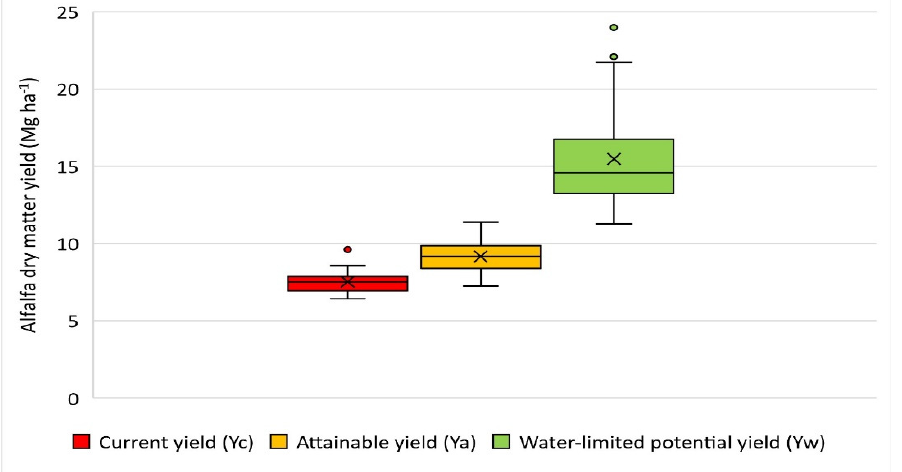
Figure 8. Estimated current yield ( Yc ), attainable yield ( Ya ) and water-limited potential yield ( Yw ) for the rainfed alfalfa-producing counties in Kansas.